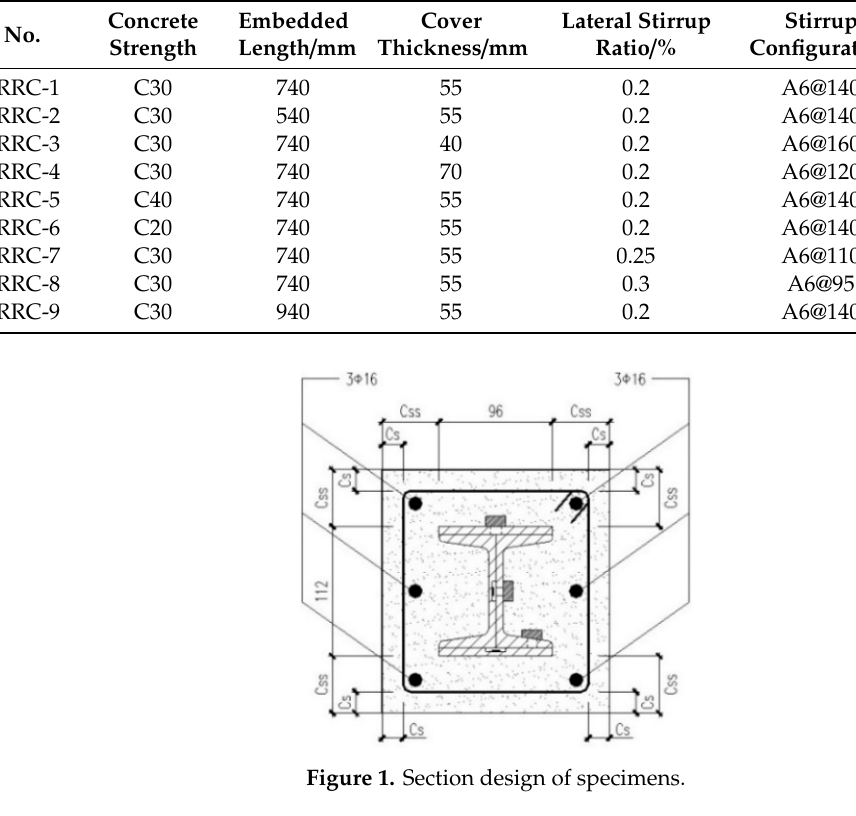
Table 3. Parameters of push-out specimens.